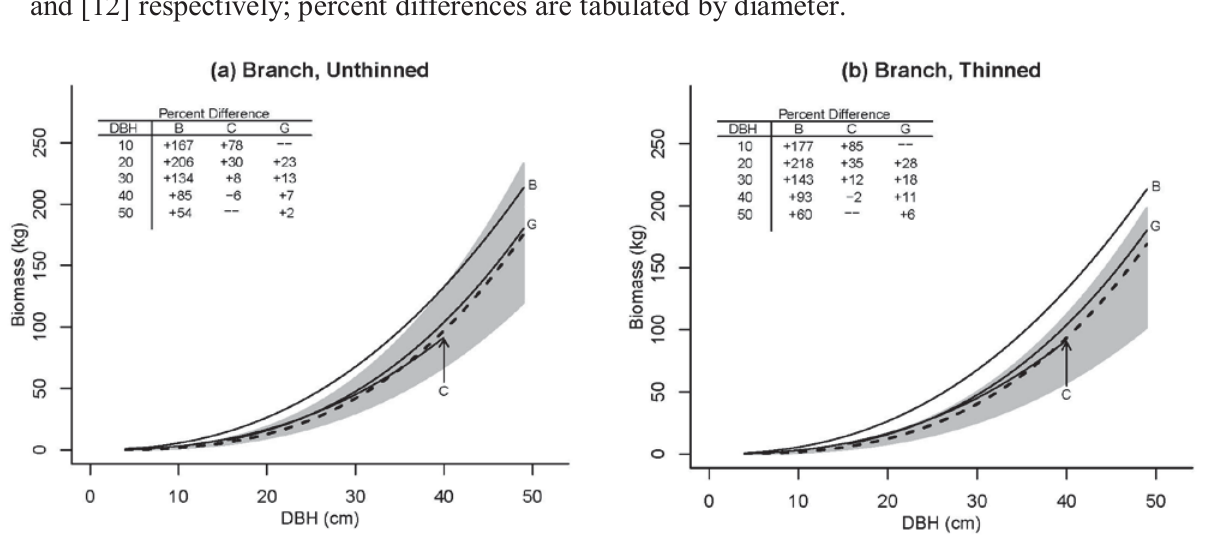
Figure 6. Estimated unthinned branch biomass ( a ) and thinned branch biomass ( b ) at BMEF with crown ratio (shaded, crown ratio from 0.40 to 0.70) and without crown ratio (dashed line) compared to three published estimates (solid lines B, C, G) from [14], [13], and [12] respectively; percent differences are tabulated by diameter.